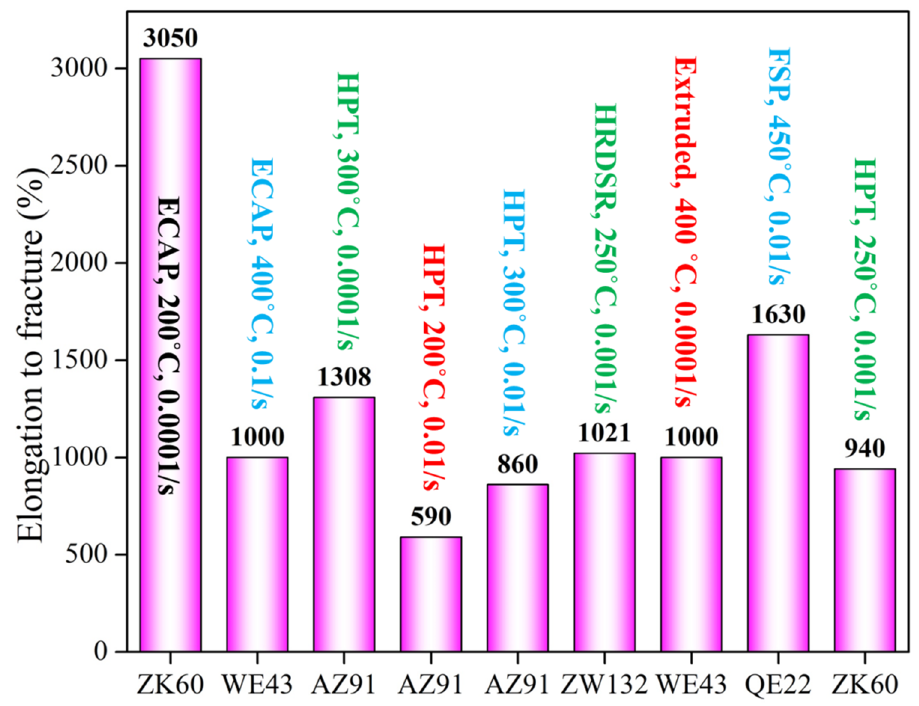
Figure 3. The processing methodologies, elongation to fracture, temperature and strain rate [18,23,25,29,34,37,39].